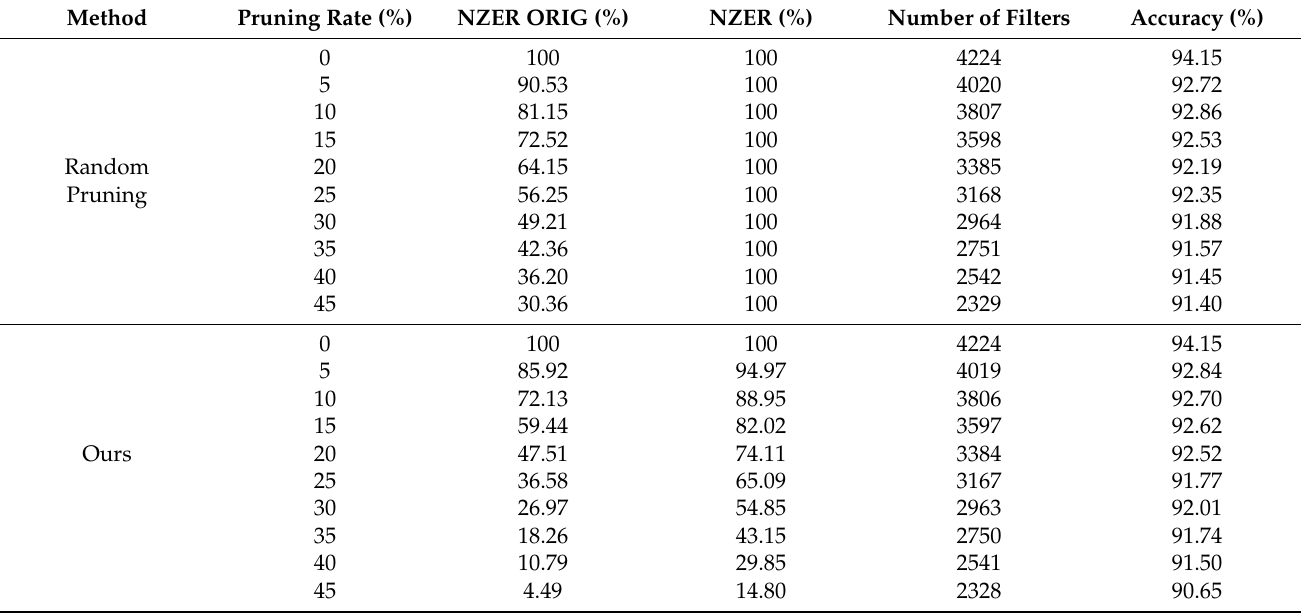
Table 2. Experiment results of filter pruning on the layers from the 1st to the 13th on VGG-16.